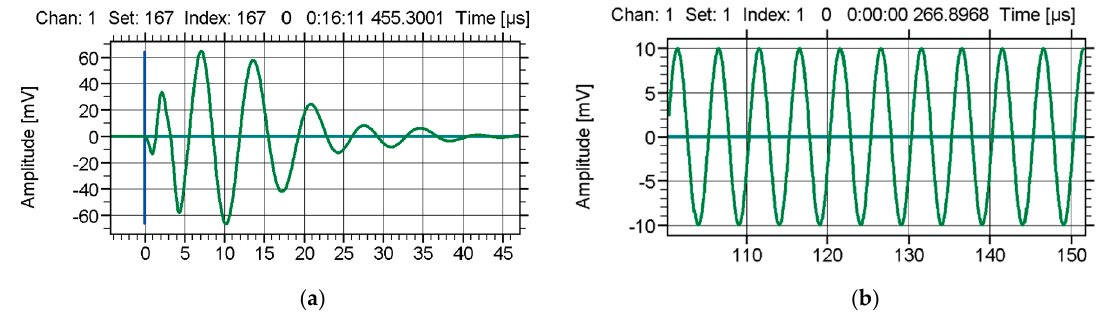
Figure 1. Examples of typical acoustic emission signals: ( a ) burst signal, ( b ) continuous signal [24].